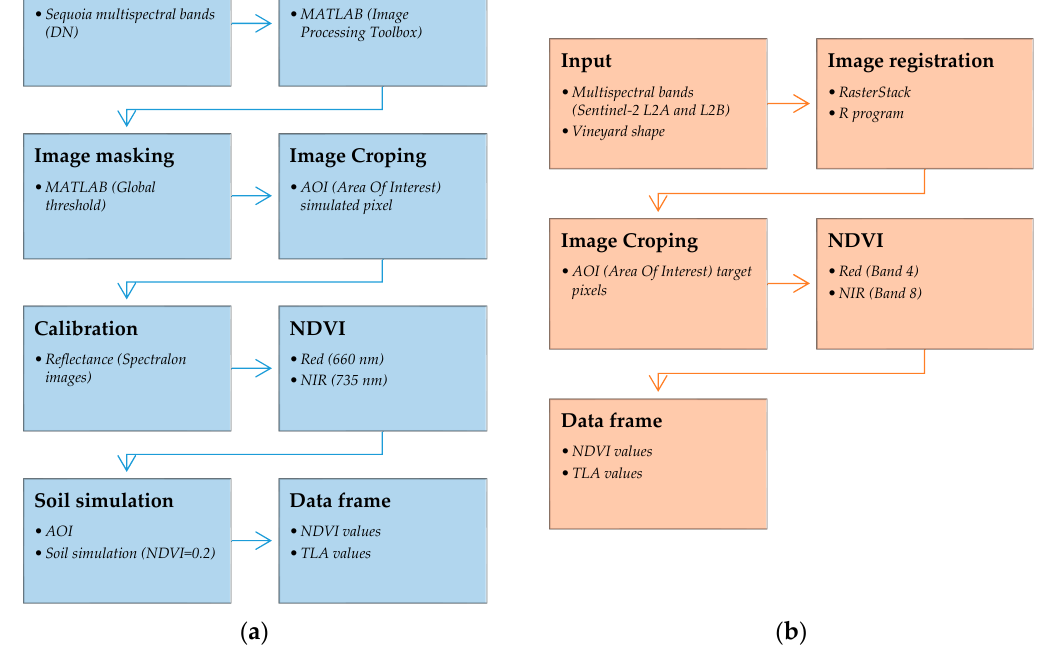
Figure 1. Pipeline of ( a ) greenhouse image analysis ( b ) field experiment image analysis. NDVI: Normalized Difference Vegetation Index. TLA: Total Leaf Area.